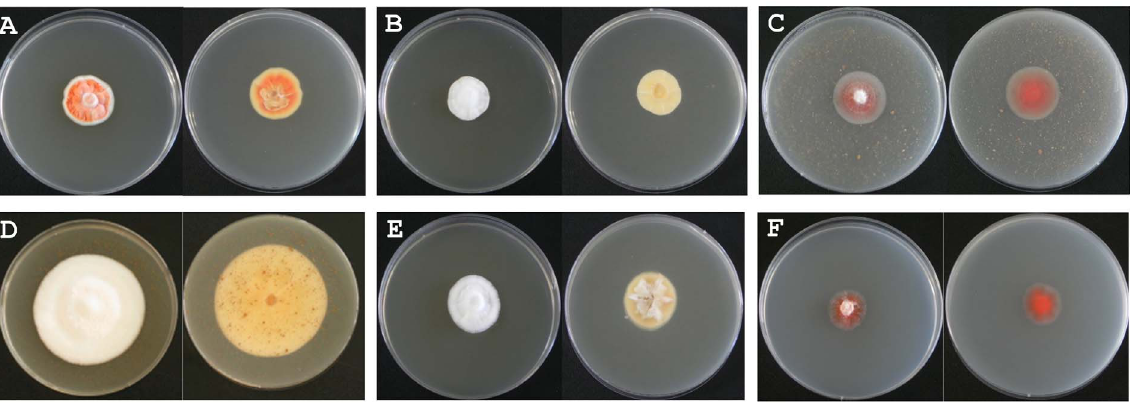
Figure 1. Morphological characteristics of C.pruinosa mycelia cultivated under various conditions. Left photo in each condition: front of plate. Right photo in each condition: back of plate. (A) S + L condition; (B) S + D condition; (C) L + D condition; (D) SL + D condition; (E) SF + D condition, (F)